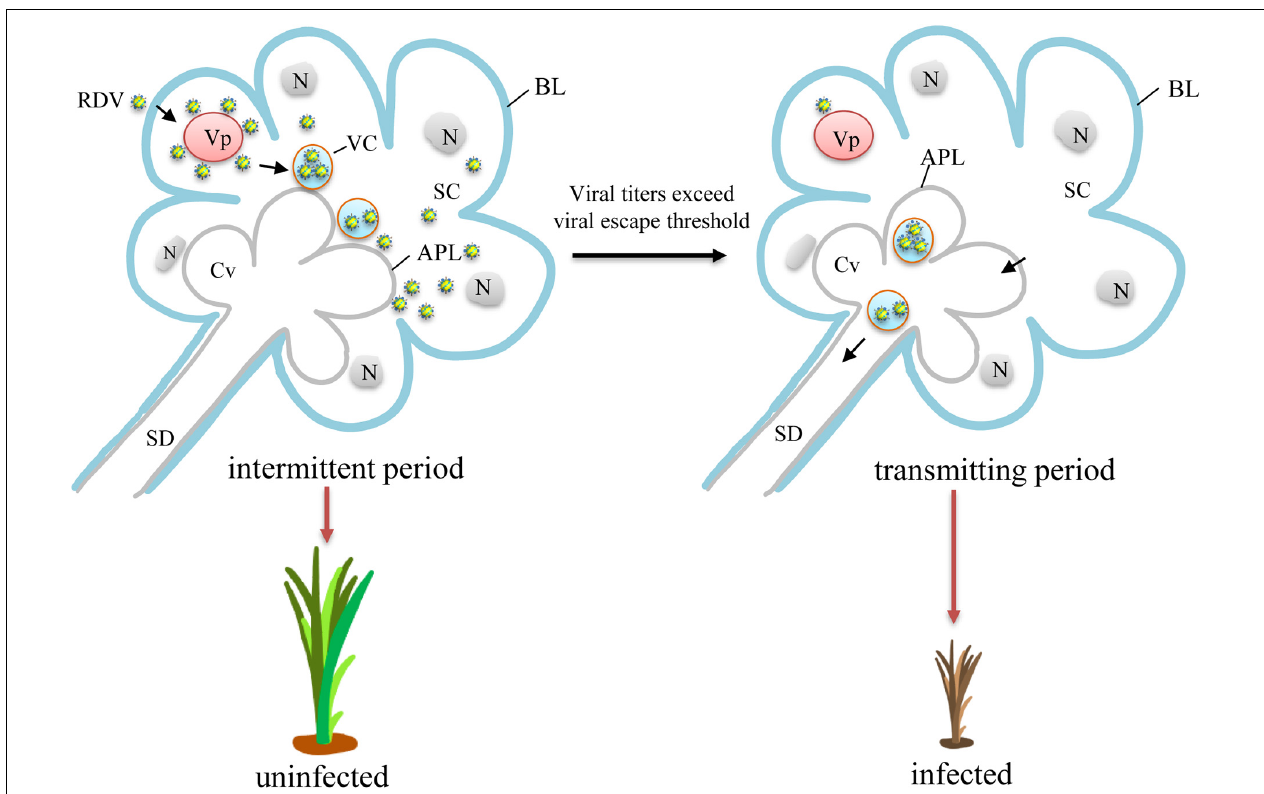
FIGURE 5 | A proposed model for viral intermittent transmission controlled by the viral release threshold. Viruses first access the cytoplasm of salivary glands and begin replication for the production of progeny virions. Abundant new virions are then formed and sequestered in vesicular compartments before their final release to salivary cavities in an exocytosis-like manner. During this process, the level of viral accumulation is still below the virus release threshold, and the leafhopper does not transmit the virus. Therefore, intermittent periods of viral transmission are observed. With the continued replication, the level of viral accumulation gradually exceeds the virus release threshold. Thus, the newly formed virions traverse the apical plasmalemma and enter the salivary cavities in a free form or using virus-laden vesicular compartments. The virions then enter the salivary duct. Once the insects feed or probe, virions are ejected with saliva into the phloem of plant hosts, causing viral infection and transmission. Vp, viroplasm; APL, apical plasmalemma; BL, basal lamina; Cv, cavity; N, nucleus; SC, salivary cytoplasm; SD, salivary duct; VC, vesicular